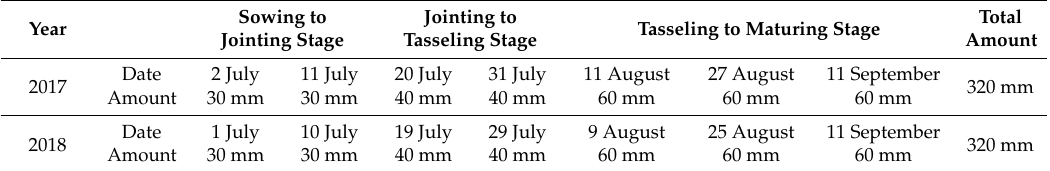
Table 2. Irrigation schedule for di ff erent growing periods in two growing